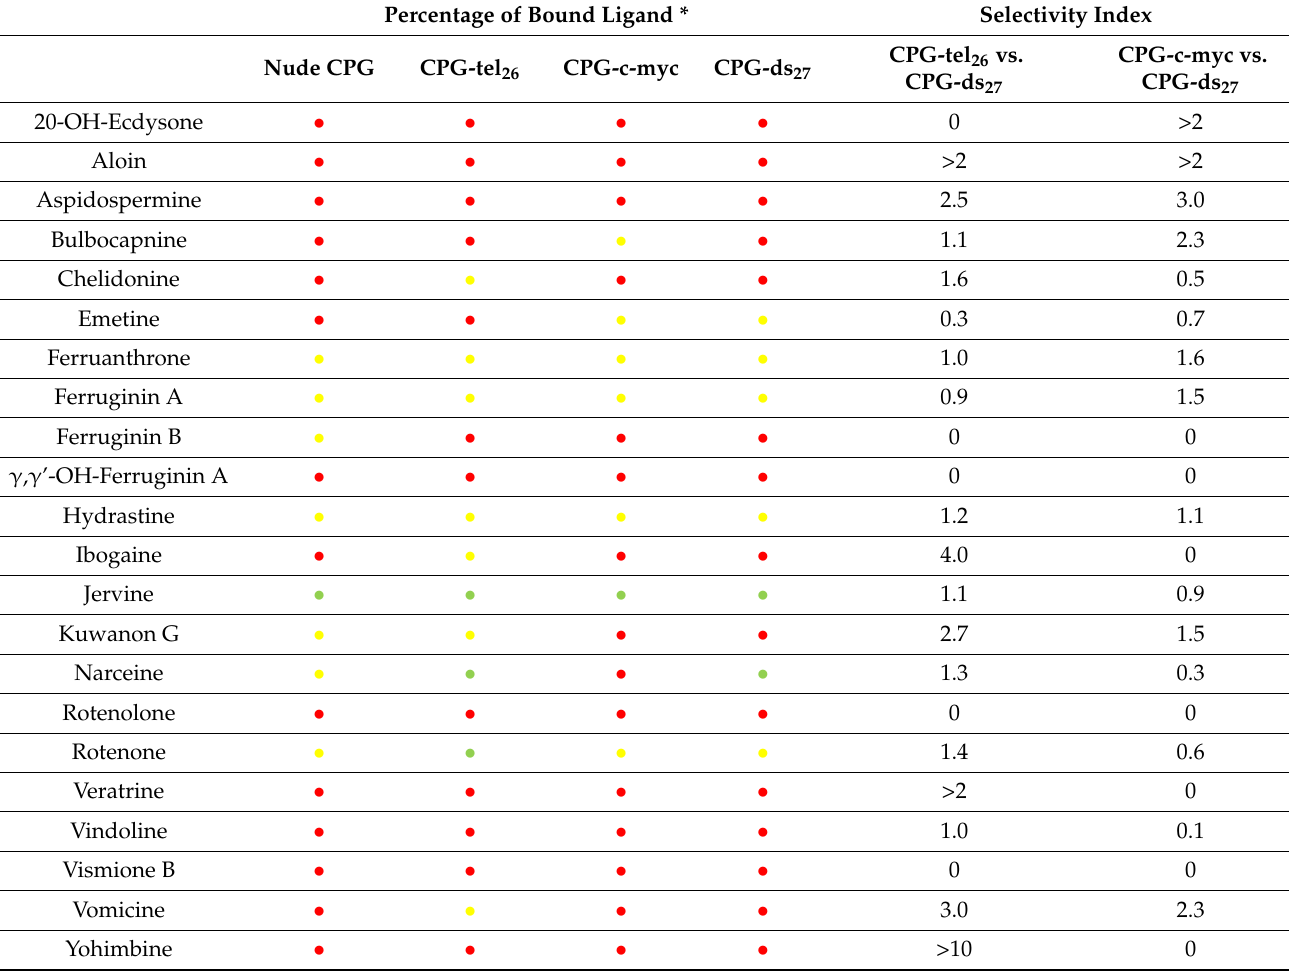
Table 1. Summary of the binding data obtained for the 28 natural compounds by the G4-CPG assay and selectivity indexes calculated as the ratio between the percentages of ligand bound to the indicated G4- and duplex-functionalized supports. Bound ligand was calculated as a difference from the unbound ligand, recovered with 50 mM KCl, 10% DMSO, 10% CH 3 CH 2 OH washing solution, and is expressed as % of the amount initially loaded on each support. The errors associated with the % are within ±